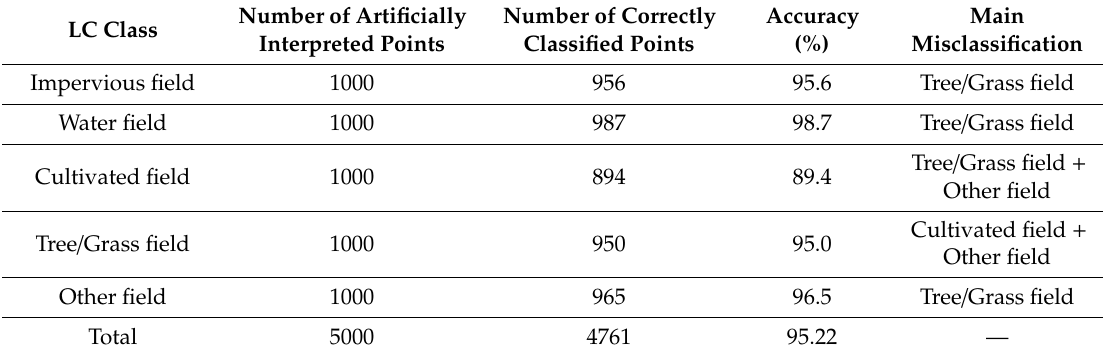
Table 4. Statistical table of itemized accuracy of each LC class for the proposed geo-object-based Auto-LCU